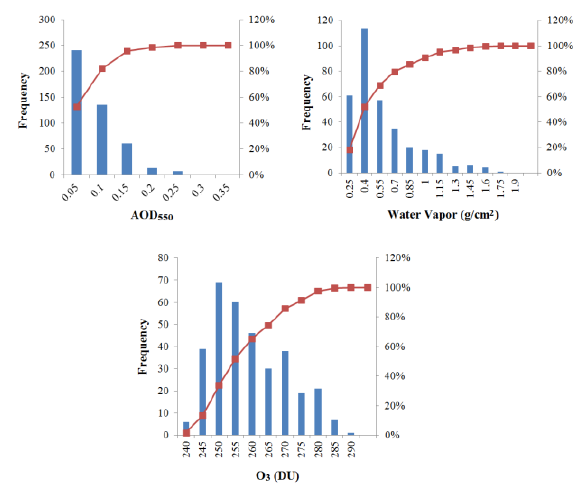
Figure 4. AOD 550 , water vapor and columnar ozone over the calibration site in Atacama.